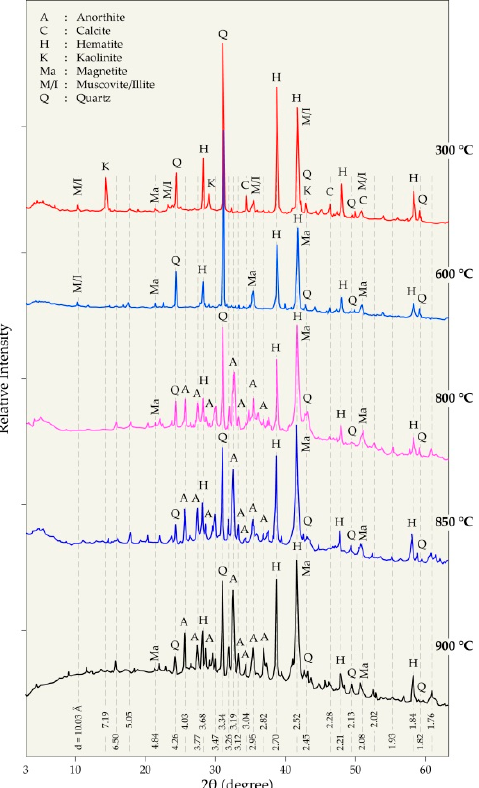
Figure 10. XRD diffractograms of the residues obtained during the treatment of pellets from 300 °C to 900 °C at 30 min.